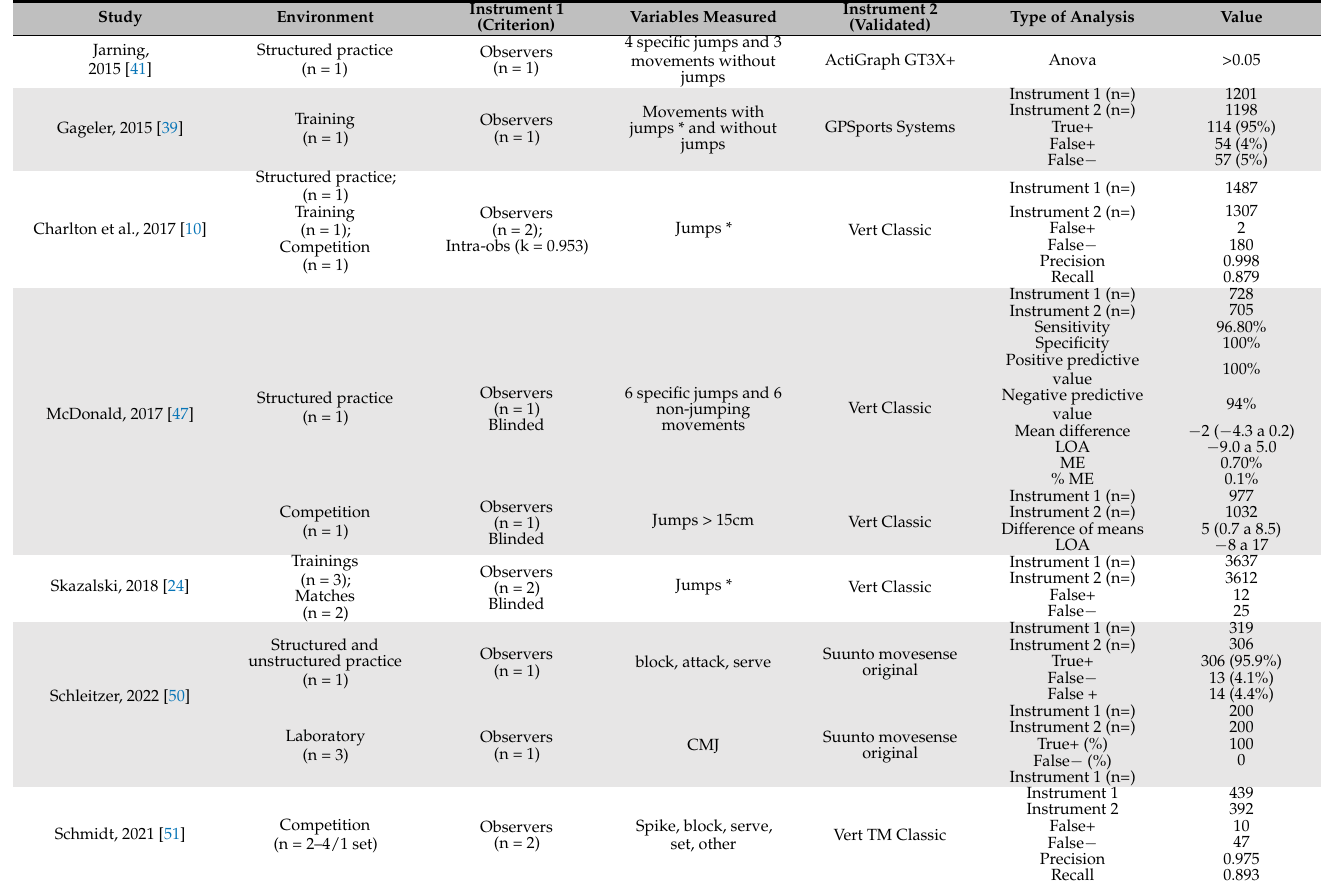
Table 5. Validity characteristics of the found